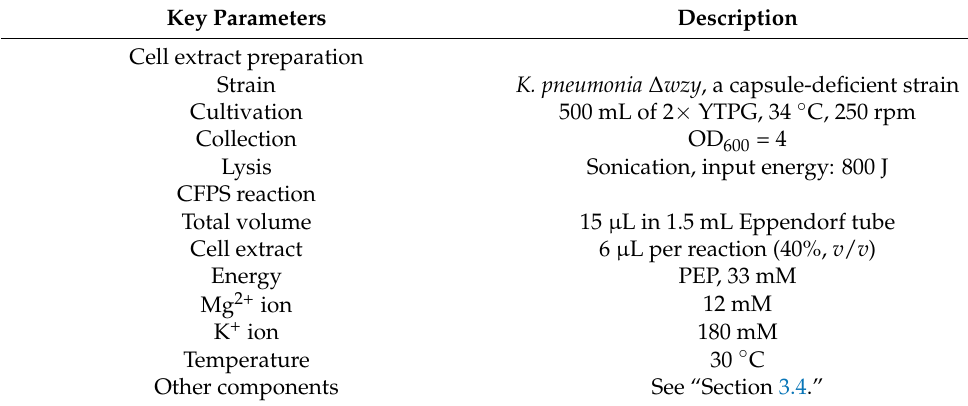
Table 2. The optimized K. pneumonia CFPS